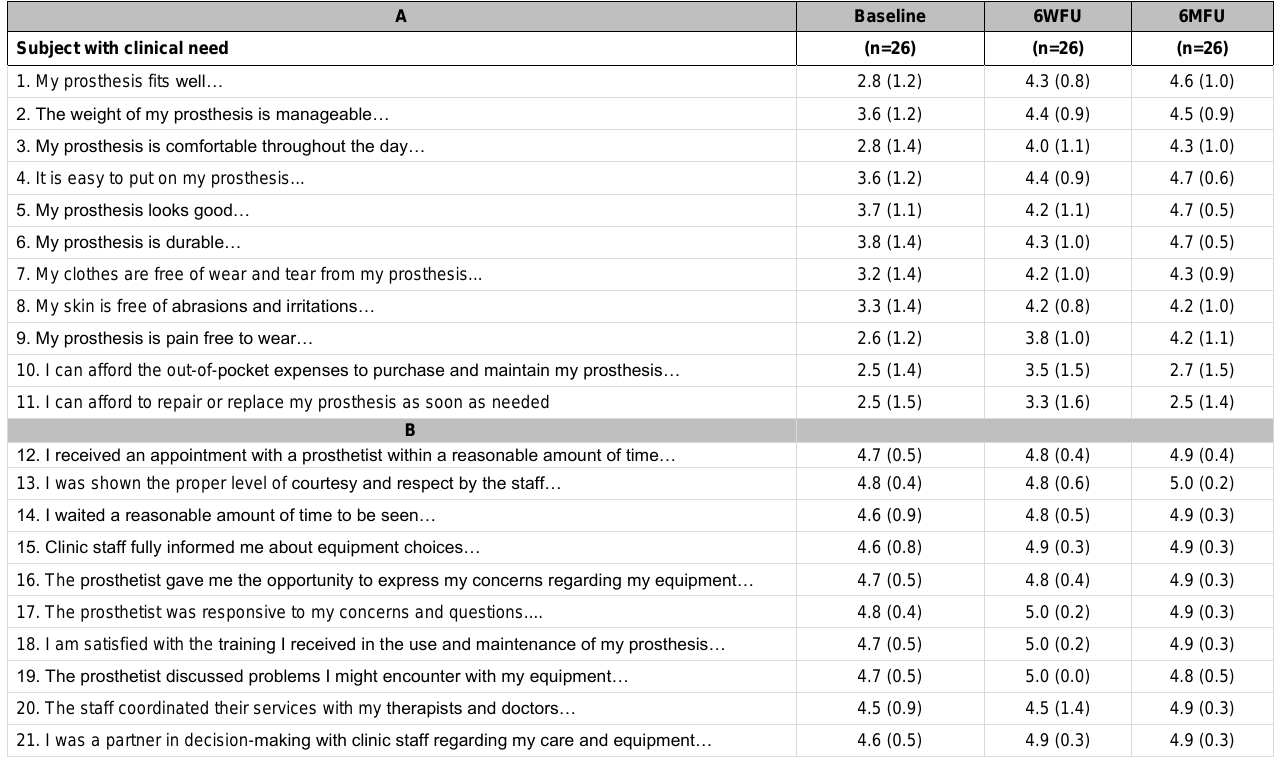
Table 4: A: OPUS Client Satisfaction Device (CSD) (questions 1-11); B: OPUS Client Satisfaction with Services (CSS) (questions 12-21).